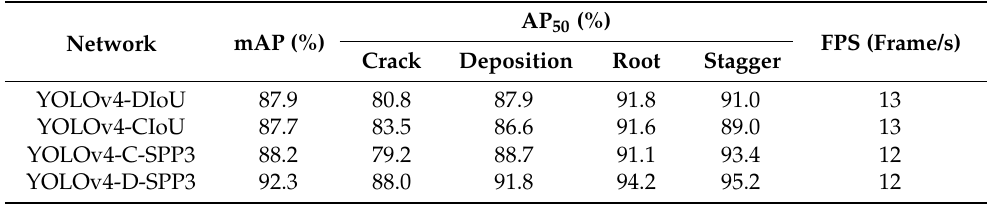
Table 5. Performance comparison of the original and improved models. Network mAP